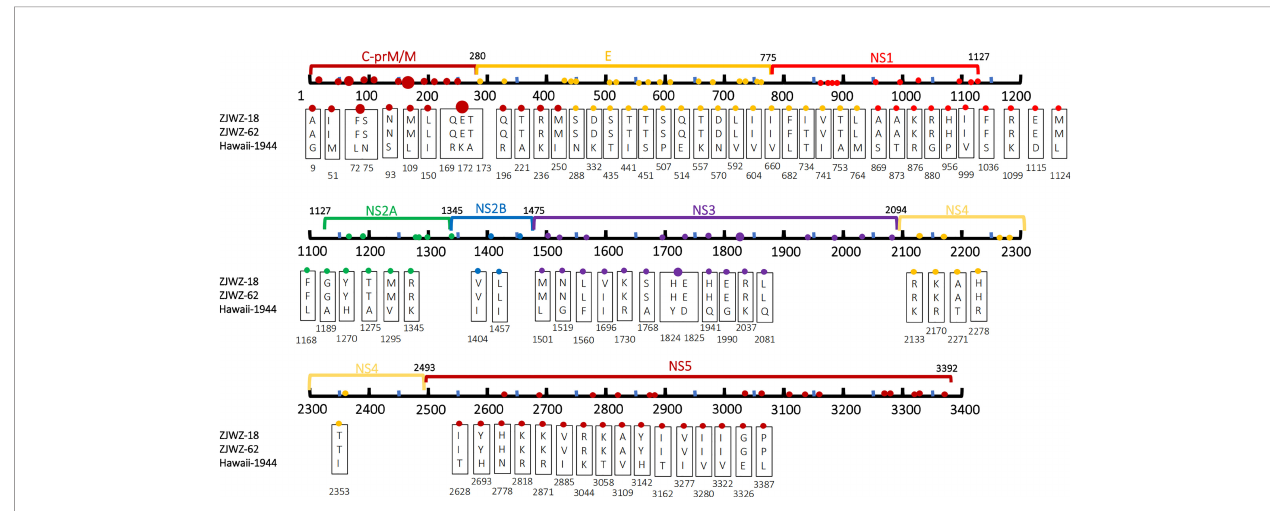
FIGURE 3 | Amino acid mutations between CDS of Wenzhou local strains and Hawaii strains (1944). The labeled numbers represent the amino acid